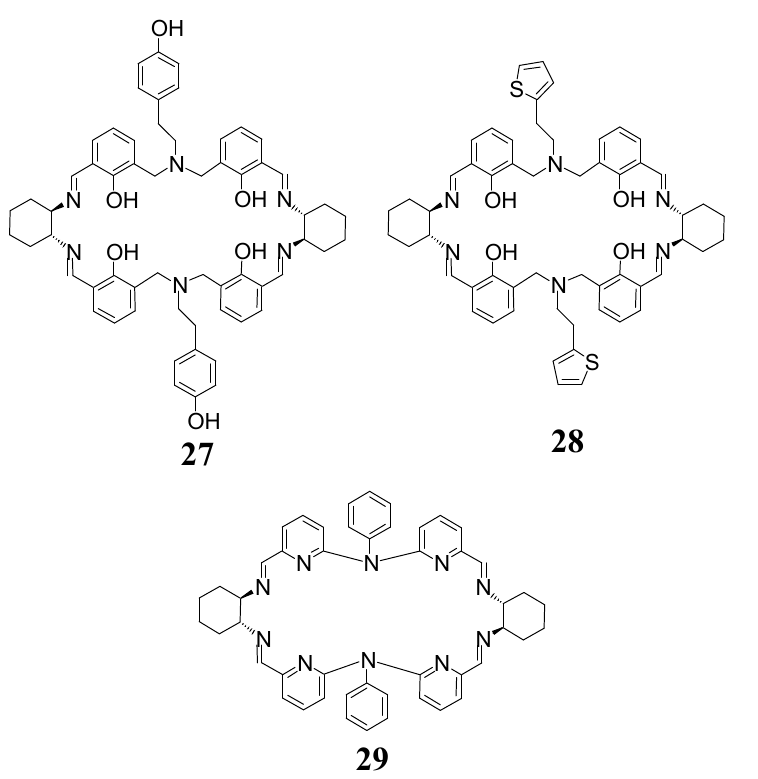
Figure 11. Extended [2 + 2] imines obtained in metal-templated condensations. The imine precursor of the extended [2 + 2] amine 30 with four pyrrole fragments (Figure 12) was obtained by the condensation of DACH L-tartarate with dipyrrolic dicarbaldehyde in the presence of triethylamine with a 90% yield. This imine was reduced with sodium borohydride to give the amine macrocycle 30 [75]. The copper(II) complex of 30 was applied as an enantioselective catalyst in a Henry reaction with up to 95% ee values. The iron complex generated from the [2 + 2] amine 31 and triiron dodecacarbonyl was used in the enantioselective hydrogenation of ketones [76,77]. This N 4 P 2 ligand contains two phosphine-type phosphorous donor atoms which allow the stabilization of the low oxidation state of iron in the active complex.